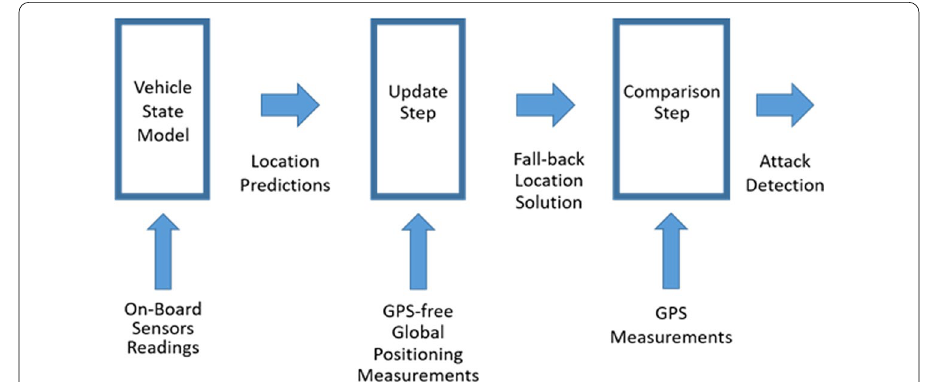
Fig. 7 In‑vehicle GPS location integrity